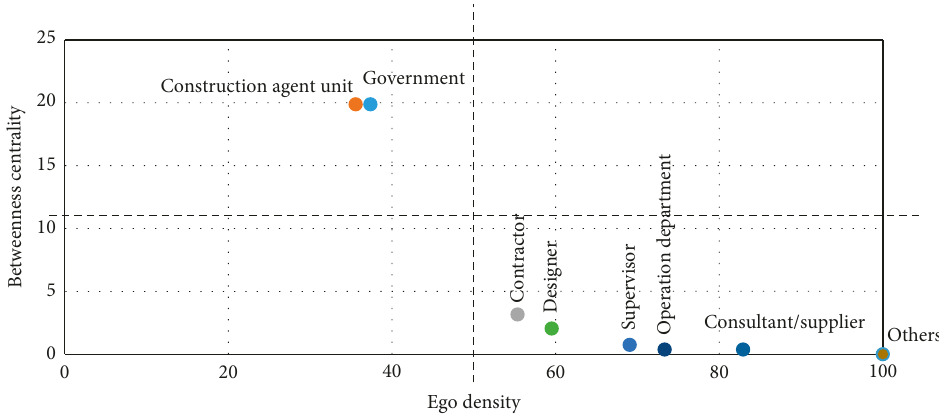
Figure 2: Position of stakeholders.